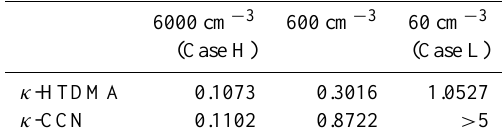
Table 1. Kappa-K¨ohler [ κ -K¨ohler ] values calculated at 90%RH ( κ -HTDMA) and at the critical point ( κ -CCN) for multiple concen-